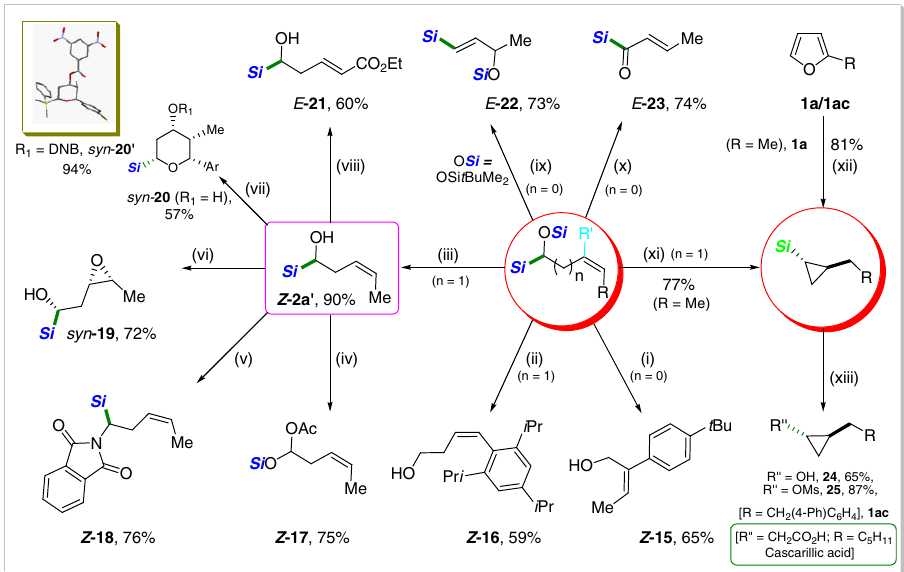
Figure 4 | Enrichment and elaboration of products. (i) CsF (5equiv.), 23 (cid:2) C, 8h, DMF, (R 0 ¼ ( t Bu)-C 6 H 4 , R ¼ Me). (ii) TBAF (3equiv., 1M in THF), 23 (cid:2) C, 15h, (R 0 ¼ H, R ¼ (2,4,6-triisopropyl)C 6 H 2 ). (iii) K 2 CO 3 (2equiv.), MeOH, 0 - 23 (cid:2) C, 4h, (R 0 ¼ H, R ¼ Me). (iv) Pb(OAc) 4 (1.1equiv.), C 6 H 6 , 0 - 23 (cid:2) C, 2h. (v) PPh 3 (1.3equiv.), Diethyl azodicarboxylate (1.3equiv.), Phthalimide (1.3equiv.), THF, 0 - 23 (cid:2) C, 20h. (vi) VO(acac) 2 (5mol%), TBHP (2.2equiv.), CH 2 Cl 2 , (cid:2) 10 - 0 (cid:2) C, 5h. (vii) p -Br-C 6 H 4 CHO (1.2equiv.), TFA (2.5equiv.), CH 2 Cl 2 (3ml), (cid:2) 20 (cid:2) C, 3h; DNB ¼ 3,5-dinitrobenzoyl. (viii) Ethyl acrylate (10equiv.), Grubbs-II (5mol%), 50 (cid:2) C, 15h. (ix) BF 3 (cid:4) Et 2 O (1.1 equiv.), CH 2 Cl 2 (0.14M), (cid:2) 78 (cid:2) C, 5h, (R 0 ¼ H, R ¼ Me). (x) (COCl) 2 (2.0equiv.), DMSO (4.0equiv.), Et 3 N (5.0equiv.), (cid:2) 78 (cid:2) C, 4h, (R 0 ¼ H, R ¼ Me). (xi) B(C 6 F 5 ) 3 (3.0mol%), PhMe 2 SiH (1.5equiv.), CH 2 Cl 2 , 0 - 23 (cid:2) C, 12h, (R 0 ¼ H, R ¼ Me). (xii) 2-Methylfuran ( 1a , 1.0equiv.), B(C 6 F 5 ) 3 (5.0mol%), Ph 2 SiH 2 (3.0equiv.), CH 2 Cl 2 , 0 - 23 (cid:2) C, 8h. (xiii) (a) 1ac (1.0equiv.), B(C 6 F 5 ) 3 (5.0mol%), Ph 2 SiH 2 (3.0equiv.), CH 2 Cl 2 , 0 - 23 (cid:2) C, 10h; (b) H 2 O 2 (20equiv.), KF (10equiv.), KHCO 3 (10equiv.), THF/MeOH (1/1), 23 (cid:2) C, 16h. ( Si ¼ SiMe 2 Ph, Si ¼ SiPh 2 H/SiMe 2